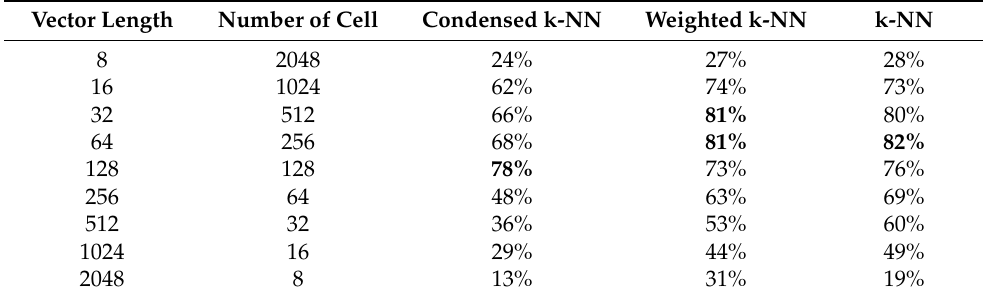
Table 5. Simulation result of structureless method with 16 KB of memory in MNIST datasets.